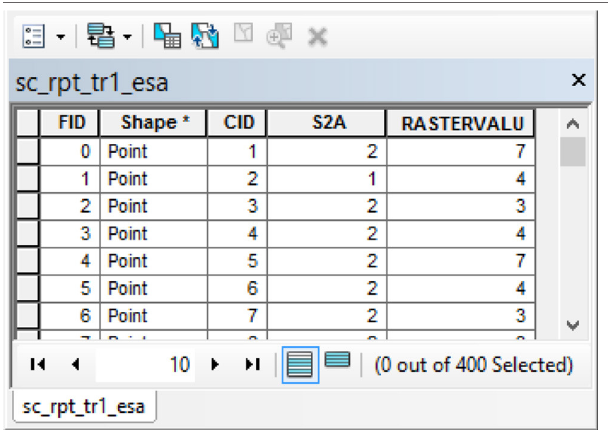
TABLE 1 | Attribute table the shapefile with LC classes.